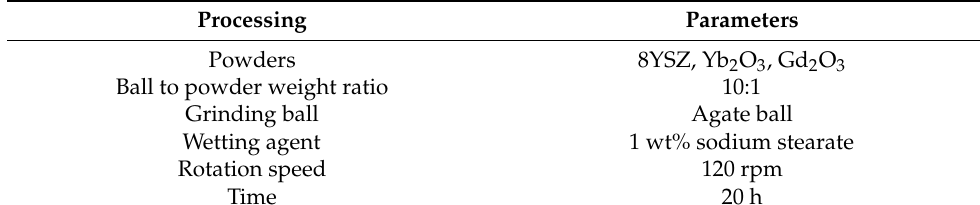
Nanjing, China) at a rotation speed of 120 rpm. The ball milling parameters were shown in Table 1. During the powders mixing process, the ball to powder weight ratio was controlled at 10:1. To avoid contamination, agate ball and jar were used. The powders’ mixing times were 20 h. One percent of sodium stearate was added as an additional wetting agent in weight. 8YSZ powder had a mean size of 30 µ m. Both Yb 2 O 3 and Gd 2 O 3 powder had a mean size of 3 µ m. The powder had a globular shape as shown in Figure 1. After mixing through ball milling, small Gd 2 O 3 and Yb 2 O 3 powders stuck to the large 8YSZ powder to form mixed powders. The mixed powders were compacted into a bulk with a diameter of 13 mm and a thickness of 3 mm through an isostatic press (ZJYP-60T, Tianjin Xinnuo Instrument Co., Ltd., Tianjin, China) under an isostatic pressure of 200 MPa for a holding time of 5 min. The detailed parameters were listed in Table 2. After cold compaction, the preform bodies were sintered at 1650 ◦ C for 6 h, 12 h, and 24 h. Table 1. Powders mixing parameters through ball milling. Processing Parameters Powders 8YSZ, Yb 2 O 3 , Gd 2 O 3 Ball to powder weight ratio 10:1 Grinding ball Agate ball Wetting agent 1 wt% sodium stearate Rotation speed 120 rpm Time 20 h